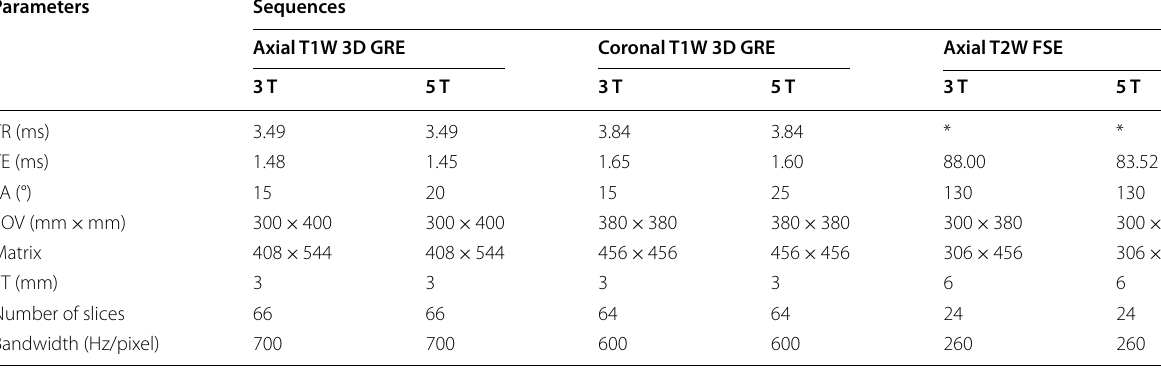
* TR depends on the respiratory interval of participants MRI magnetic resonance imaging; T1W T1-weighted; T2W T2-weighted; GRE gradient-echo; FSE fast spin echo; TR repetition time; TE echo time; FA flip angle; FOV field of view; ST slice thickness